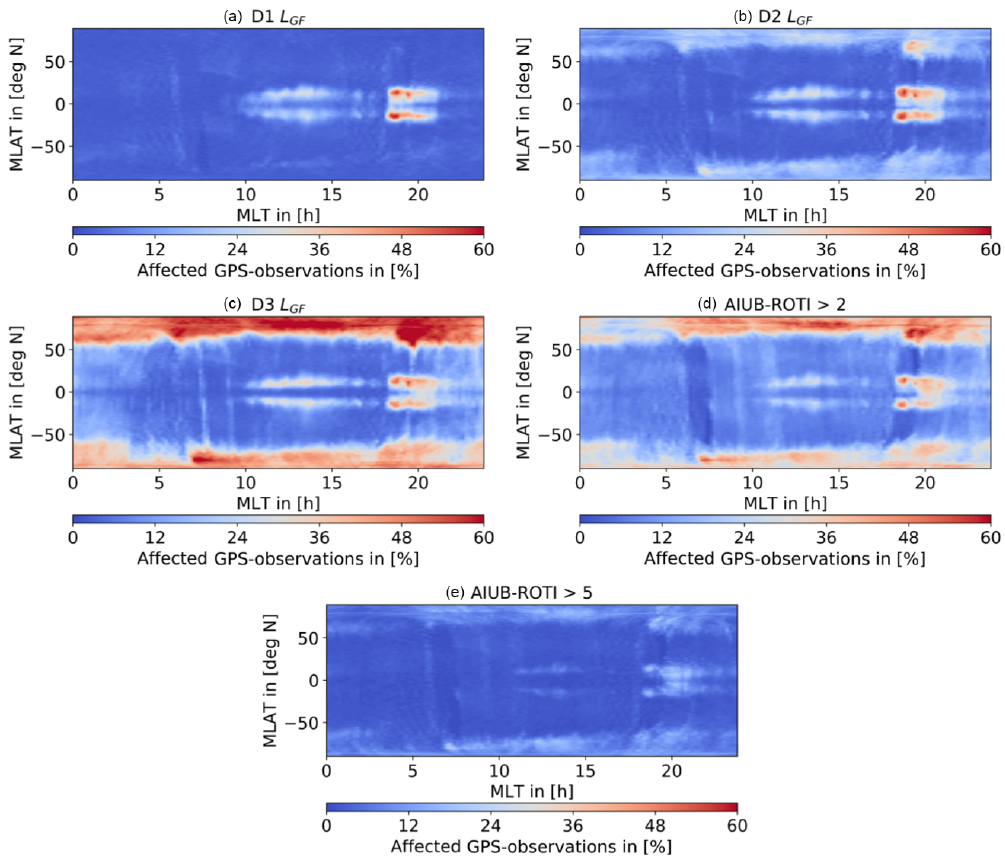
Figure 10. Percentage of weighted raw GPS measurements for the analyzed test period; 2015: January, March; 2016: February, March, June, July, August, binned to the corresponding LEO position. (a, b) D1 L GF (a) , D2 L GF (b) , (c, d) D3 L GF (c) , ROTI > 2 (d) , and (e) ROTI > 5. Bin size 1 ◦ Mlat × 0 .